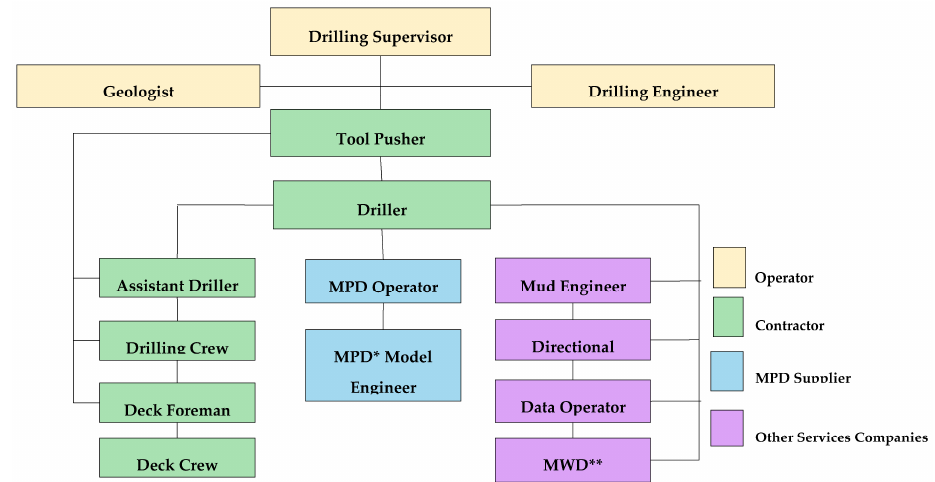
Figure 11. Communication structure during offshore drilling operation [30]. * Managed pressure drilling; ** Measurement while drilling.